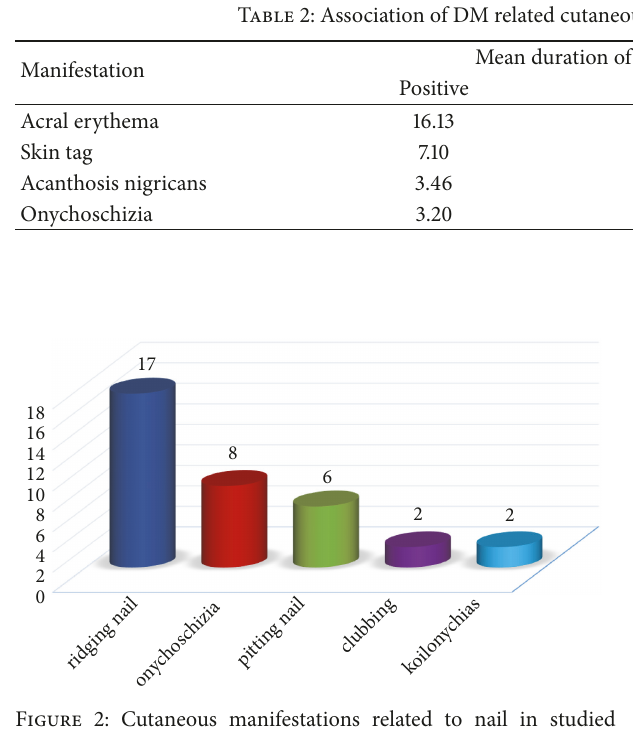
Figure 2: Cutaneous manifestations related to nail in studied diabetic patients in terms of the prevalence